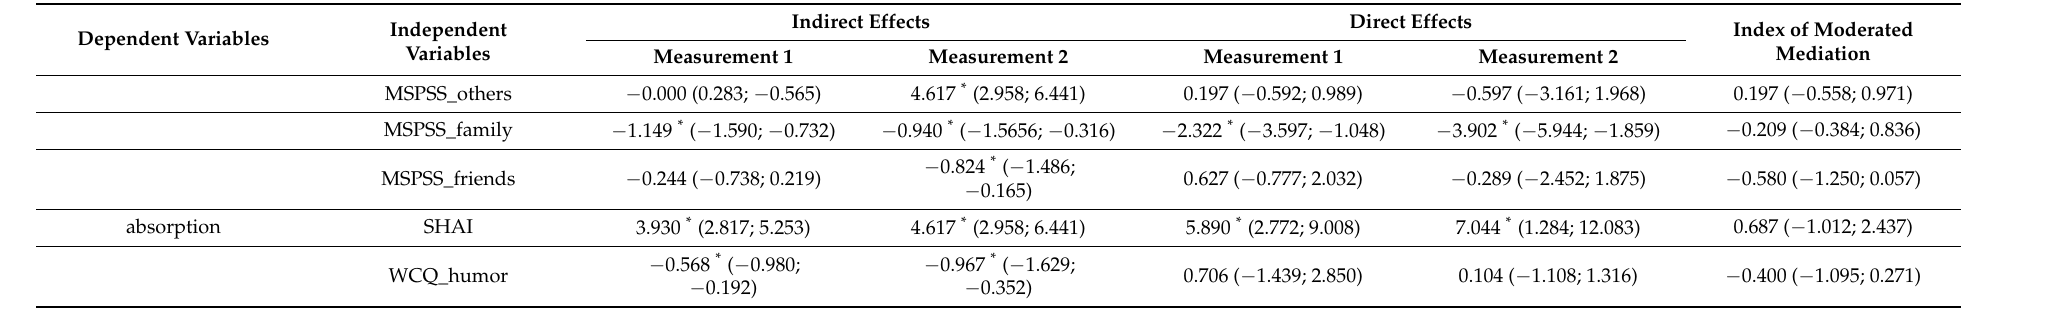
Table 6. Coefficients of the linear regression of the Hungarian